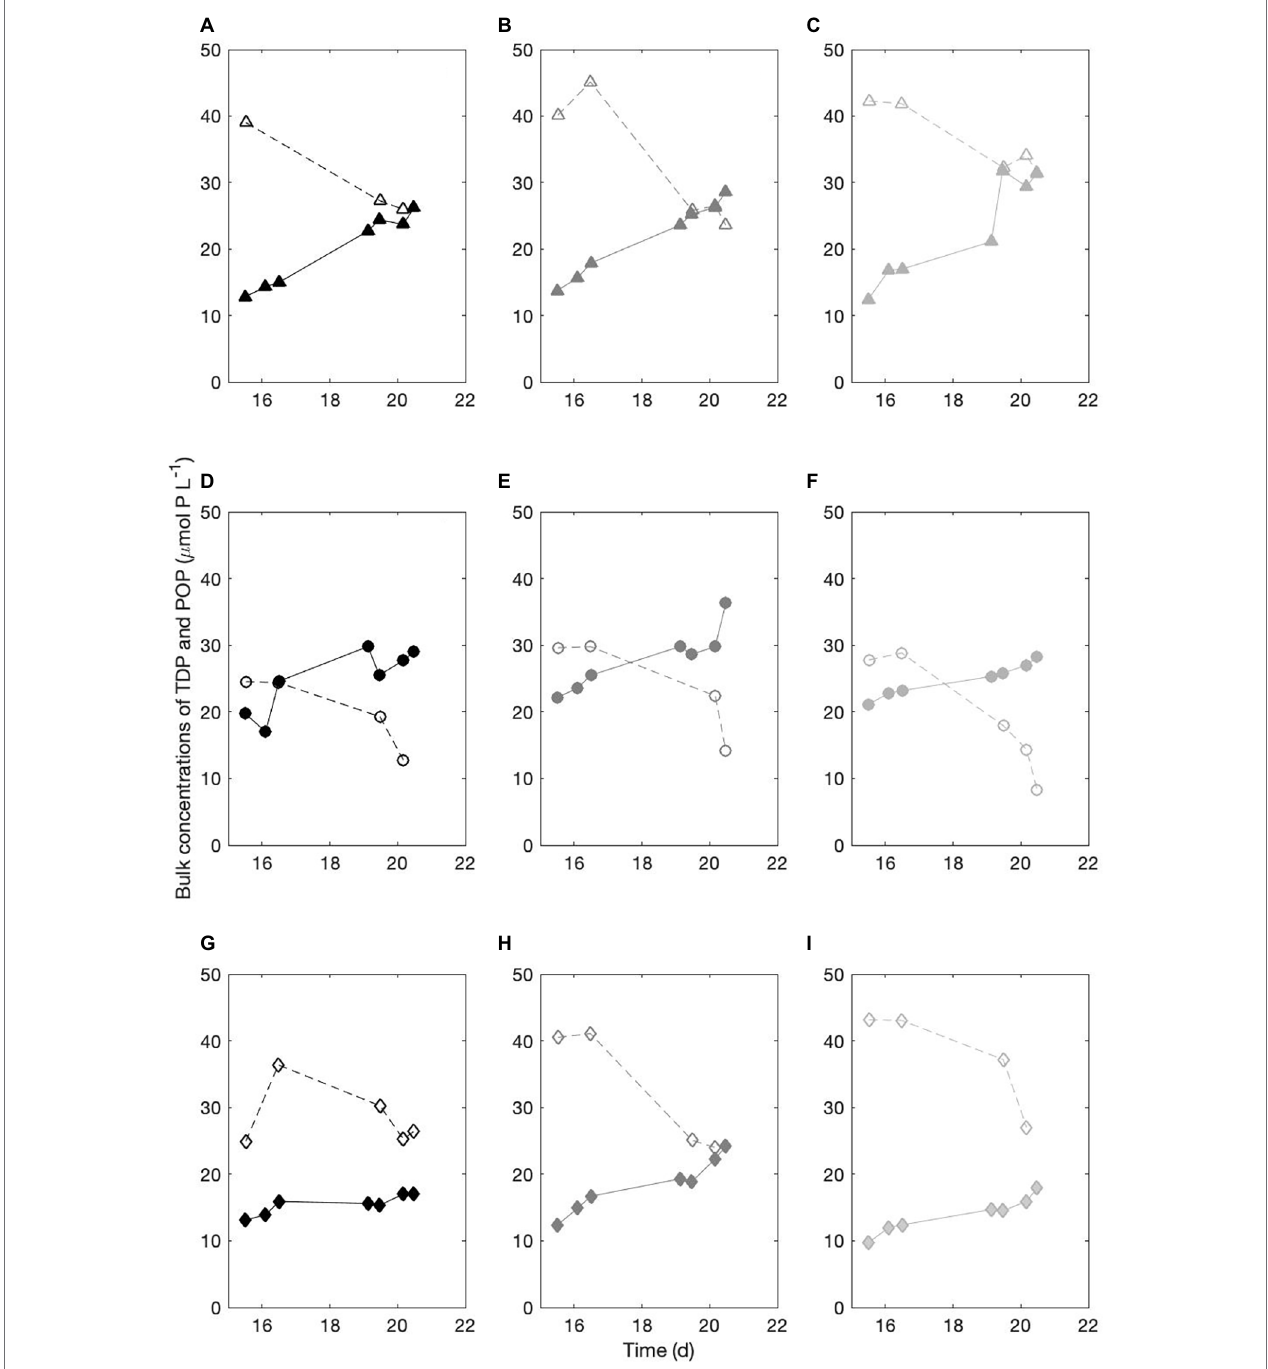
FIGURE 3 | Temporal dynamics of the bulk, total dissolved and particulate phosphorus pools. (A-C) three replicates of the PO 4 culture; (D-F) three replicates of the AMP culture; (G-I) three replicates of the Alpha culture. Open symbols, TDP concentrations in μ mol P L − 1 . Closed symbols, POP concentrations in μ mol P L − 1